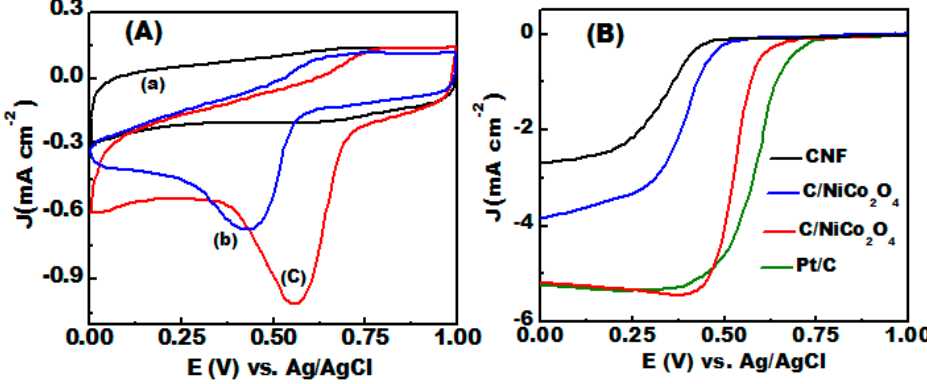
Figure 6. ORR electrocatalytic performances of the synthesized catalysts measured in N 2 or O 2 - saturated 0.1 M KOH solutions: ( A ) CVs of the catalysts obtained at 50 mVs − 1 scan rates at room temperature of (a) C/NiCo 2 O 4 in N 2 -saturated solution (b) NiCo 2 O 4 in O 2 -saturated solution and (c) C/NiCo 2 O 4 in O 2 -saturated solution; and ( B ) LSVs responses of the prepared catalysts recorded at 1600 rpm compared with commercial Pt/C catalyst.